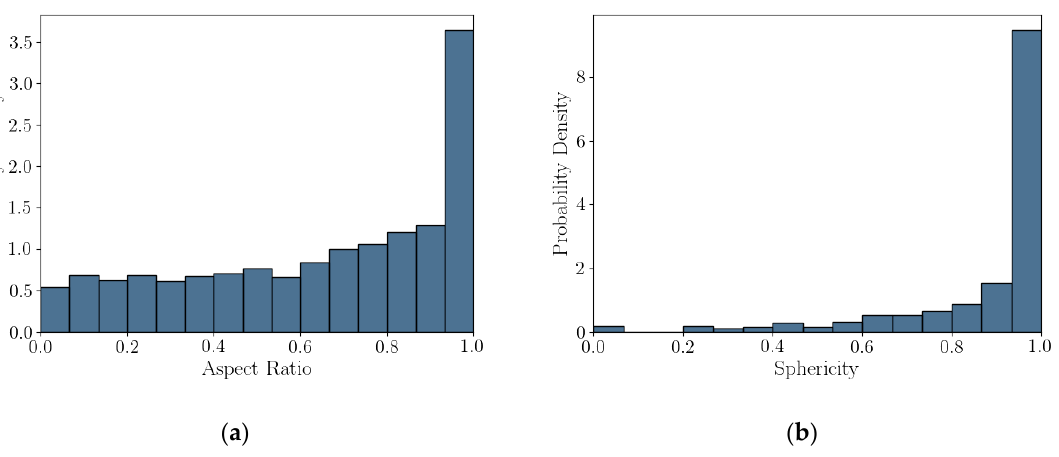
Figure 12. Particle shape parameter histograms of a disc rotated about an axis sampled at 10,000 random angles. ( a ) Aspect ratio and ( b ) sphericity.